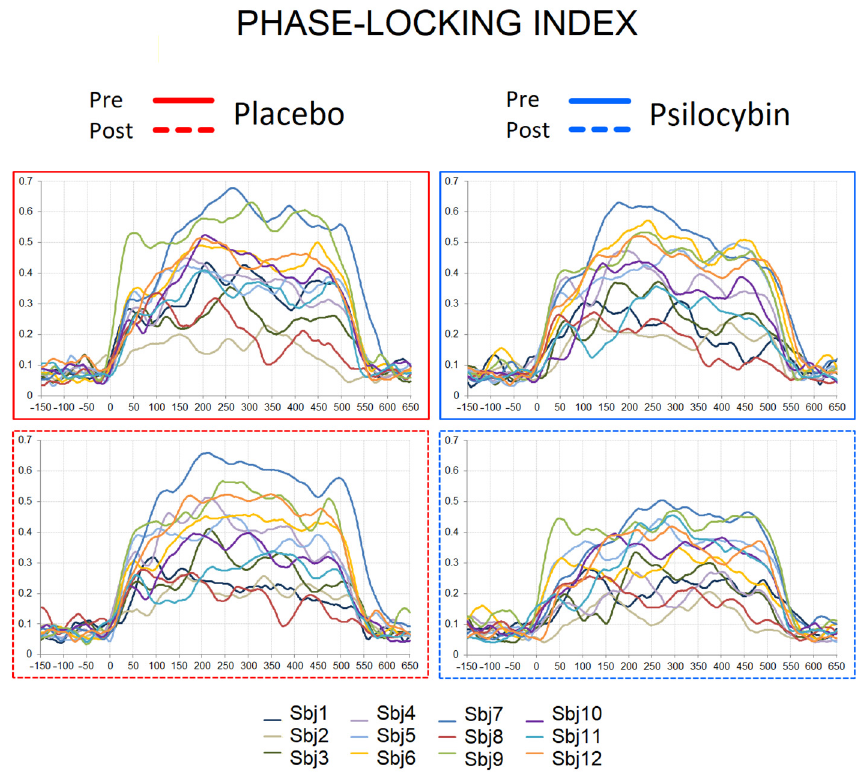
Figure 2. Individual PLI curves in pre-placebo, post-placebo, pre-psilocybin and post-psilocybin conditions. X axis—time in milliseconds, Y axis—PLI values.